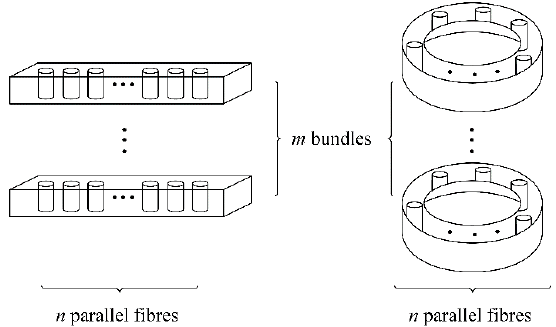
Figure 2. The composite is modeled as a chain with m links, each link consisting of a bundle with n parallel fibers [21].